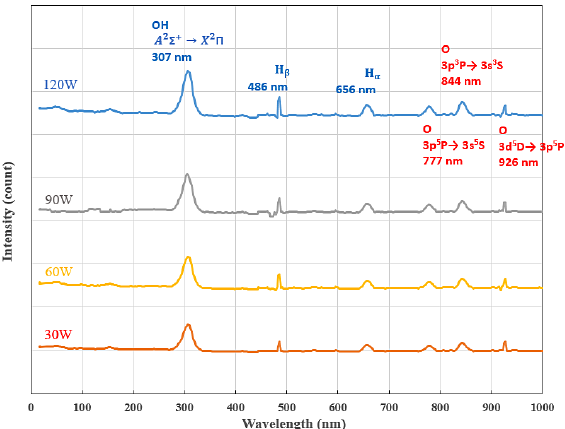
Figure 4. OES after applying of pressurized H 2 O plasma for sample treatment at a fixed (2.8 kVpp) discharge voltage. At this condition, the OH radical spectrum has a very high intensity at plasma powers of 30, 60, 90 and 120 W.